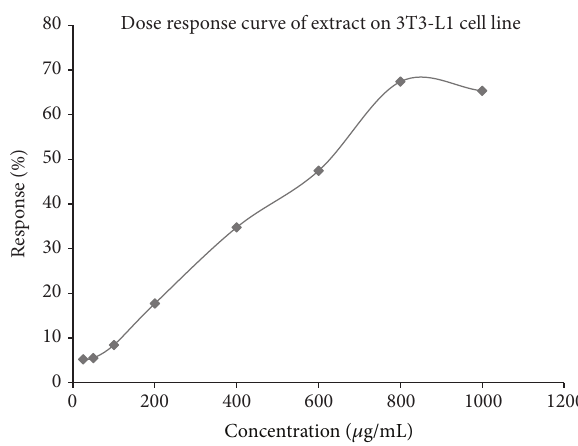
Figure 2: Dose response curve of extract for 3T3-L1 cell line. Values are expressed as mean ± SEM (number of experiments, 𝑛 = 6 ). Dose response curve of the extract revealed poor discrimination at 25 𝜇 g/mL and showed greater sensitivity at 200 𝜇 g/mL. Ceiling effect observed at 1000 𝜇 g/mL where no more increase in the response is seen with further increase in the dose. Extract exhibited the inhibitory effect with an inhibitory concentration (IC 50 ) of 662.14 𝜇